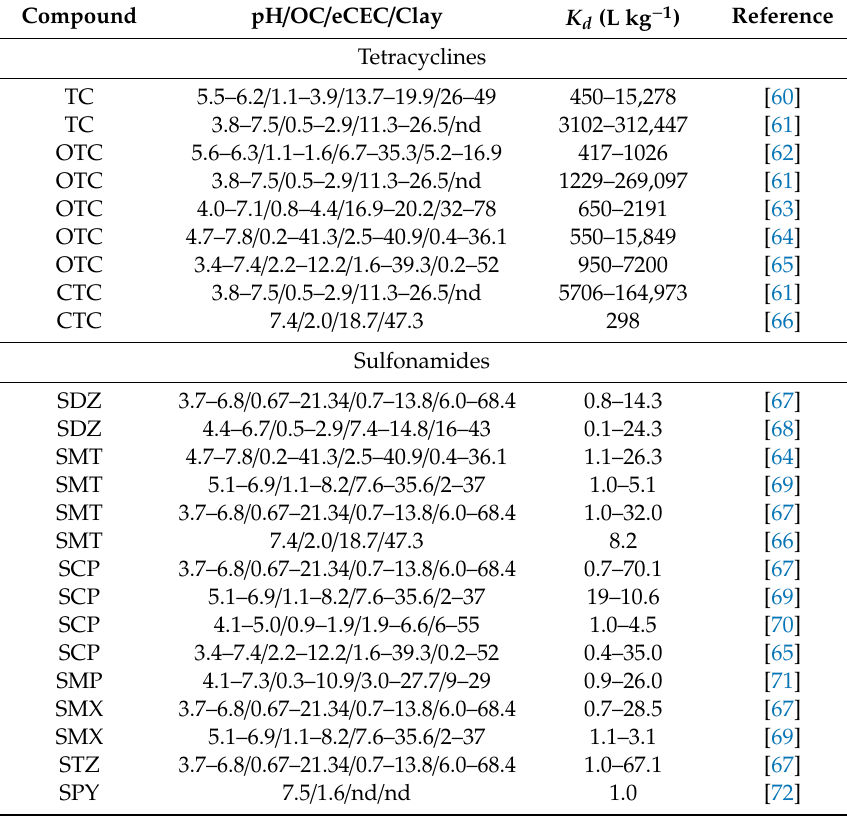
Table 6. Partition coe ffi cient ( K d ) for di ff erent tetracycline and sulfonamide antibiotics in various